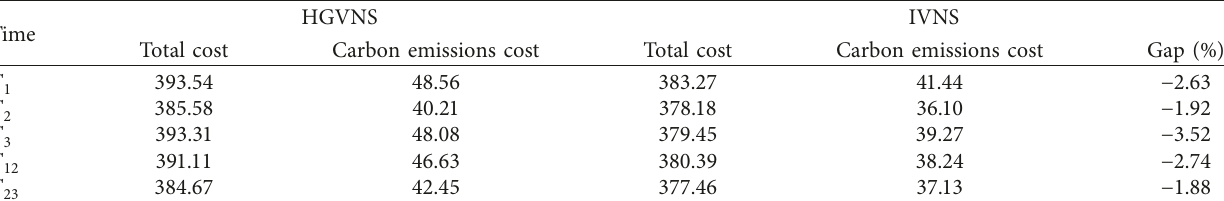
Table 12: Comparing the IVNS with